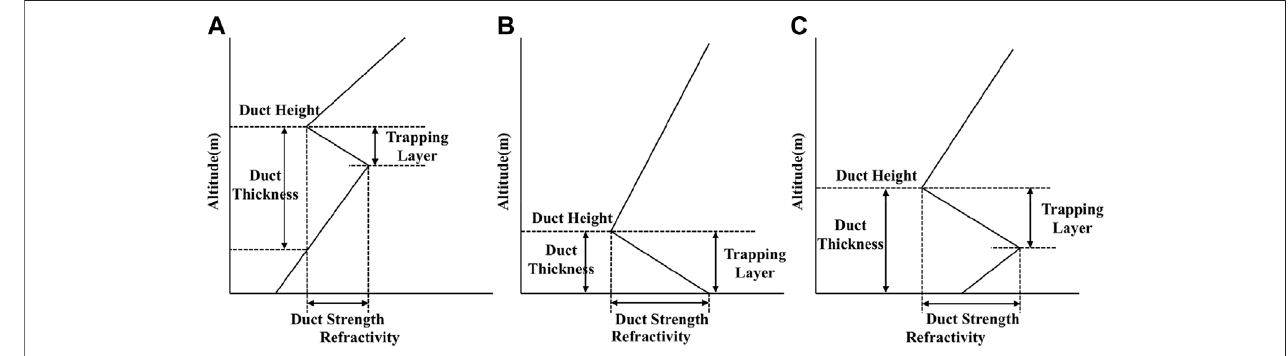
FIGURE 2 | Vertical refractivity pro fi les of surface ducts (A) , surface-based ducts (B) , and elevated ducts (C) , and the characteristics of